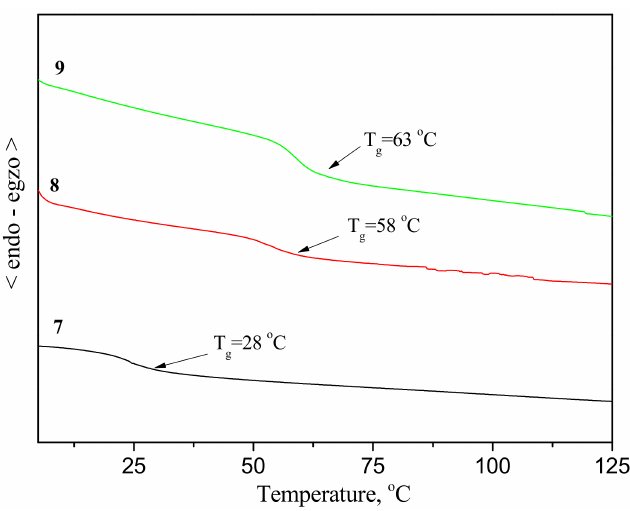
Figure 1. Differential scanning calorimetry (DSC) curves of polymers 7 – 9 . Heating rate was 10 ◦ C/min.